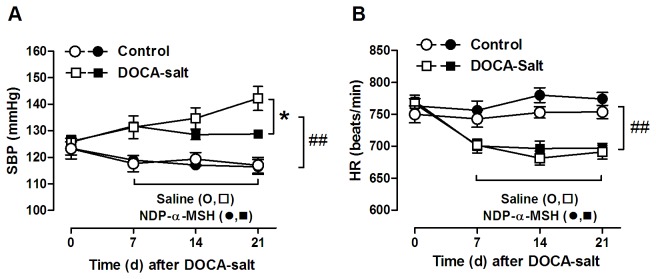
NDP-α-MSH treatment prevents the elevation of blood pressure in DOCA-salt mice.Systolic blood pressure (A) and heart rate (B) in control and DOCA-salt treated mice measured by a tail cuff method. After 7 days on the control and DOCA-salt treatments mice were randomized to daily i.p. injections of either saline or NDP-α-MSH (0.3 mg/kg). Data are mean ± SEM of six mice per group. * P < 0.05 versus saline-treated DOCA-salt mice, # # P < 0.01 versus control mice.